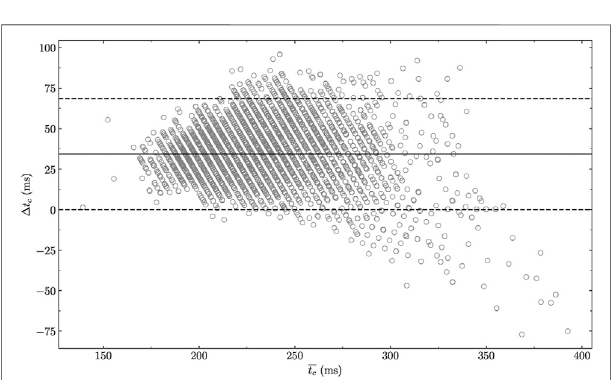
FIGURE 6 | BlandAltman plot comparing experimentally measured and reconstructed t c usingthemultivariatepolynomialmodelgivenby Eq.3 ,which reports a systematic bias of 34.3 ms (95% con fi dence intervals [33.8 ms, 34.7 ms]). Δ t c : measured t c − reconstructed t c and t c : average of measured and reconstructed t c